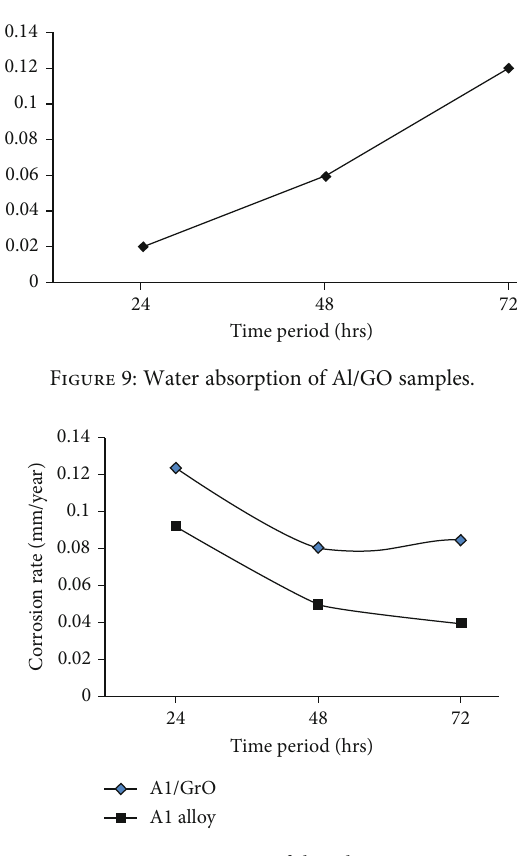
Figure 10: Corrosion rates of the Al/GO composites.